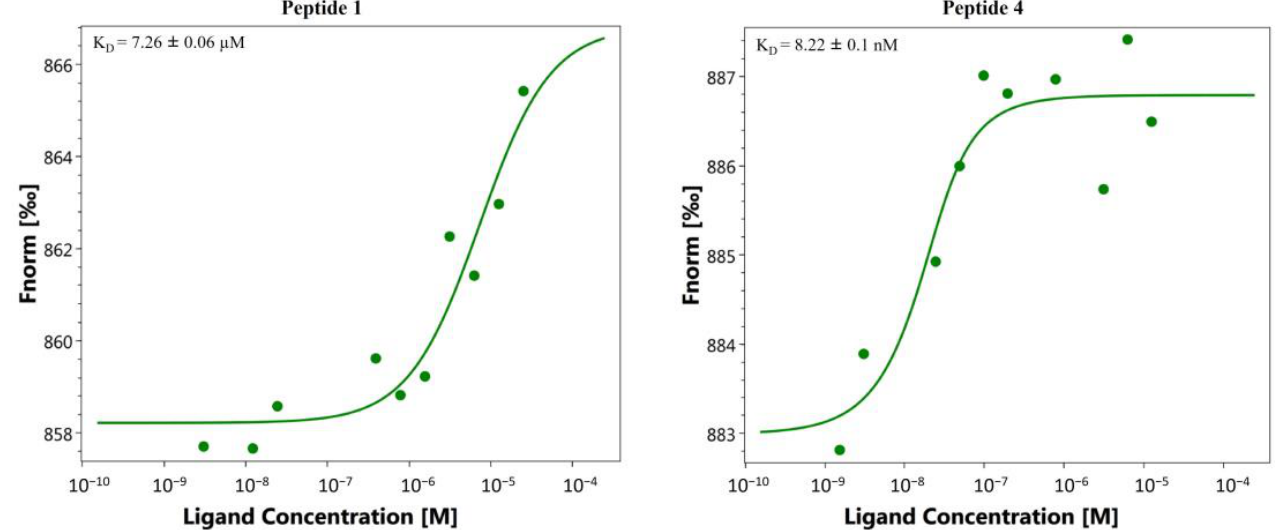
Figure 2. Direct binding measurements of the interaction between HA (H1N1 hemagglutinin, Cat No.: Z03181, GenScript, NE) and peptide 1 and 4 . MST binding affinity assays were performed as described in the Materials and Methods section (Section 3). Representative single dose–response curves of peptides 1 and 4 binding to HA are shown; F norm , normalized fluorescence. Experiments were repeated independently three times. Reported K D is the mean ± SD of three independent experiments.